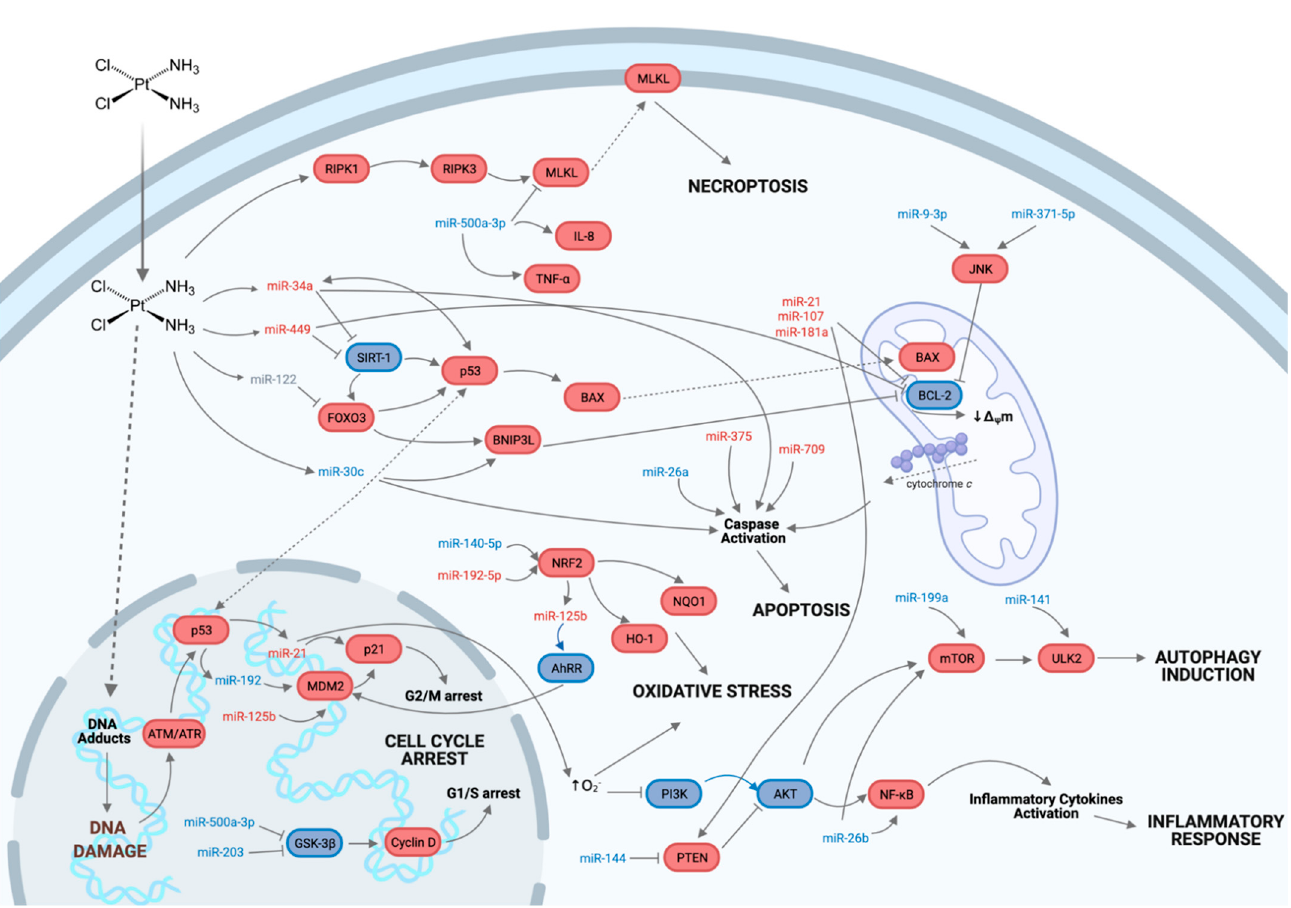
Figure 3. Proposed model of miRs function in the activation of different signaling pathways during cisplatin-induced nephrotoxicity in rodent and human tubular cells. Block arrows indicate inhibitory effect; single arrows indicate stimulatory effect. The blue color indicates gene expression down-regulation, while the red color indicates gene expression up-regulation. Created with BioRender.com accessed on 21 May